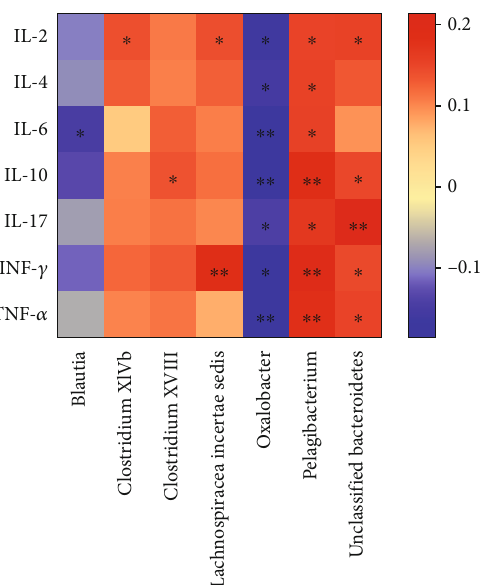
Figure 7: A heat map shows the correlation between di ff erent gut microbial species and cytokines. Colors indicate the